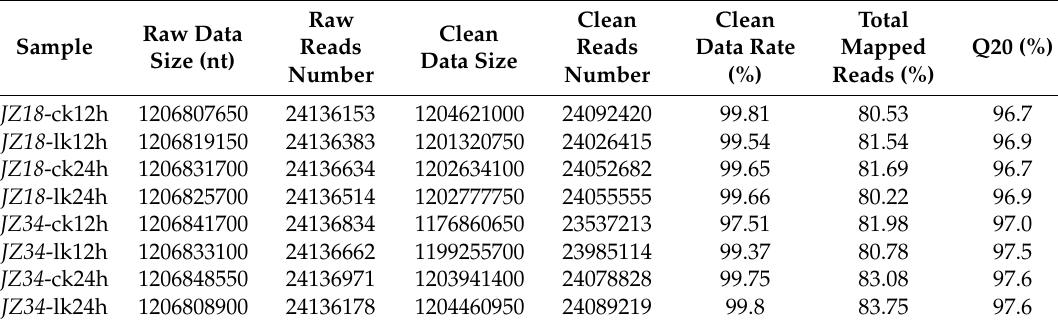
Table 2. Overview of the digital gene expression profiling of the sequencing